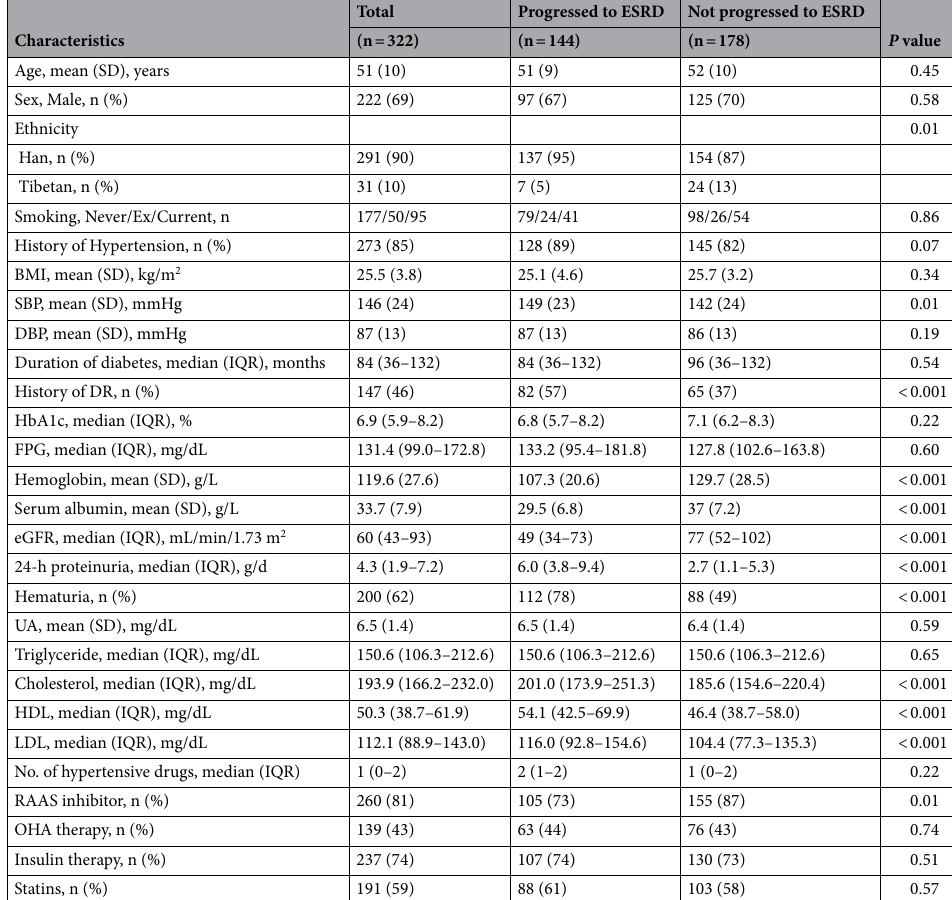
Table 1. Sociodemographic and clinical characteristics of the participants at the time of biopsy. Data are presented as means (SDs) for continuous variables with a normal distribution, as medians (25th–75th percentiles) for continuous variables without a normal distribution, and as percentages for categorical variables. BMI, body mass index; SBP, systolic blood pressure; DBP, diastolic blood pressure; MAP, mean blood pressure; DR, diabetic retinopathy; CKD, chronic kidney disease; FPG, fasting plasma glucose; BUN, blood urea nitrogen; eGFR, estimated glomerular filtration rate; UA, uric acid; HDL, high-density lipoprotein- cholesterol; LDL, low-density lipoprotein-cholesterol; RAAS, renin–angiotensin–aldosterone system inhibitor; OHA, oral hypoglycaemic